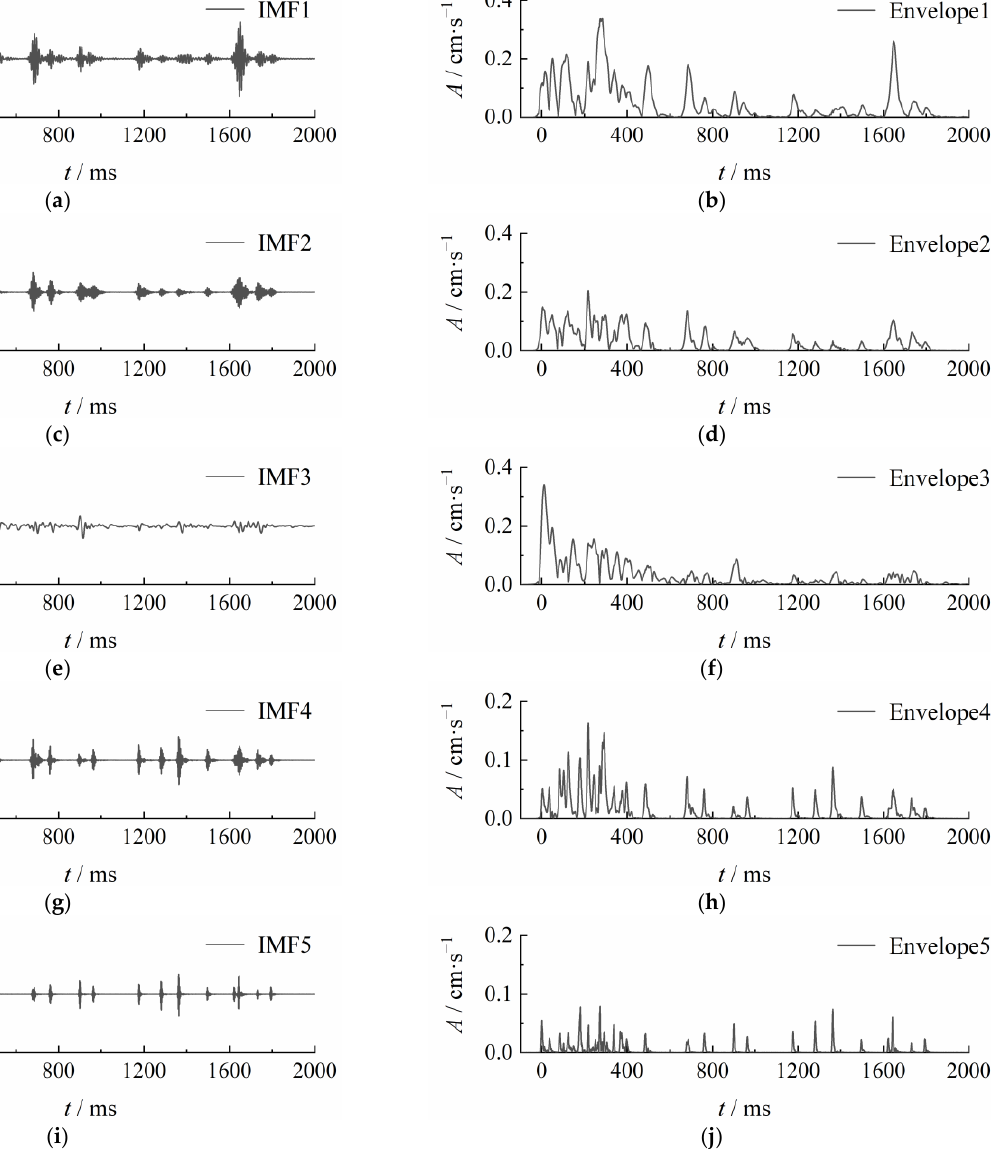
Figure 6. IMF components and envelopes: ( a ) IMF component 1; ( b ) Envelope 1; ( c ) IMF component 2; ( d ) Envelope 2; ( e ) IMF component 3; ( f ) Envelope 3; ( g ) IMF component 4; ( h ) Envelope 4; ( i ) IMF component 5; ( j ) Envelope 5.